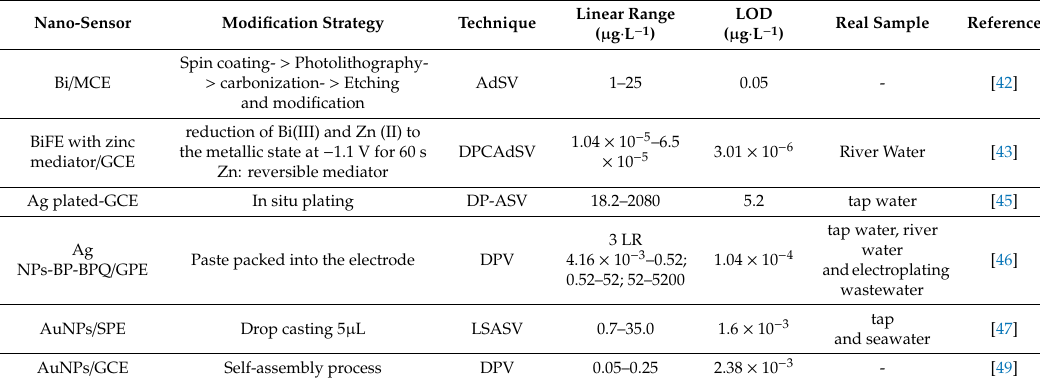
Table 2. Summary of the electroanalytical data of reported modified electrodes by metallic nanoparticles for hexavalent chromium